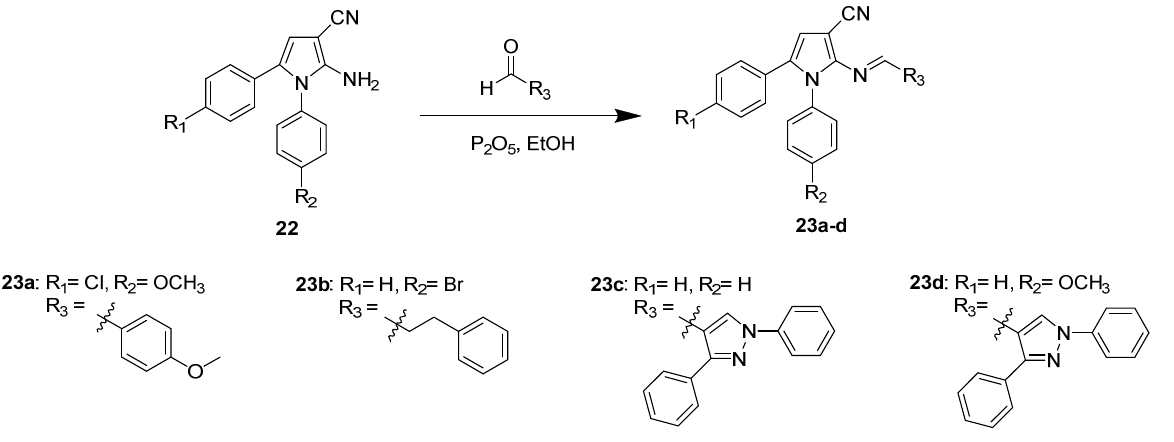
Table 4. Anti-HSV-1 activity and docking score of analogs 27a – d and Acyclovir